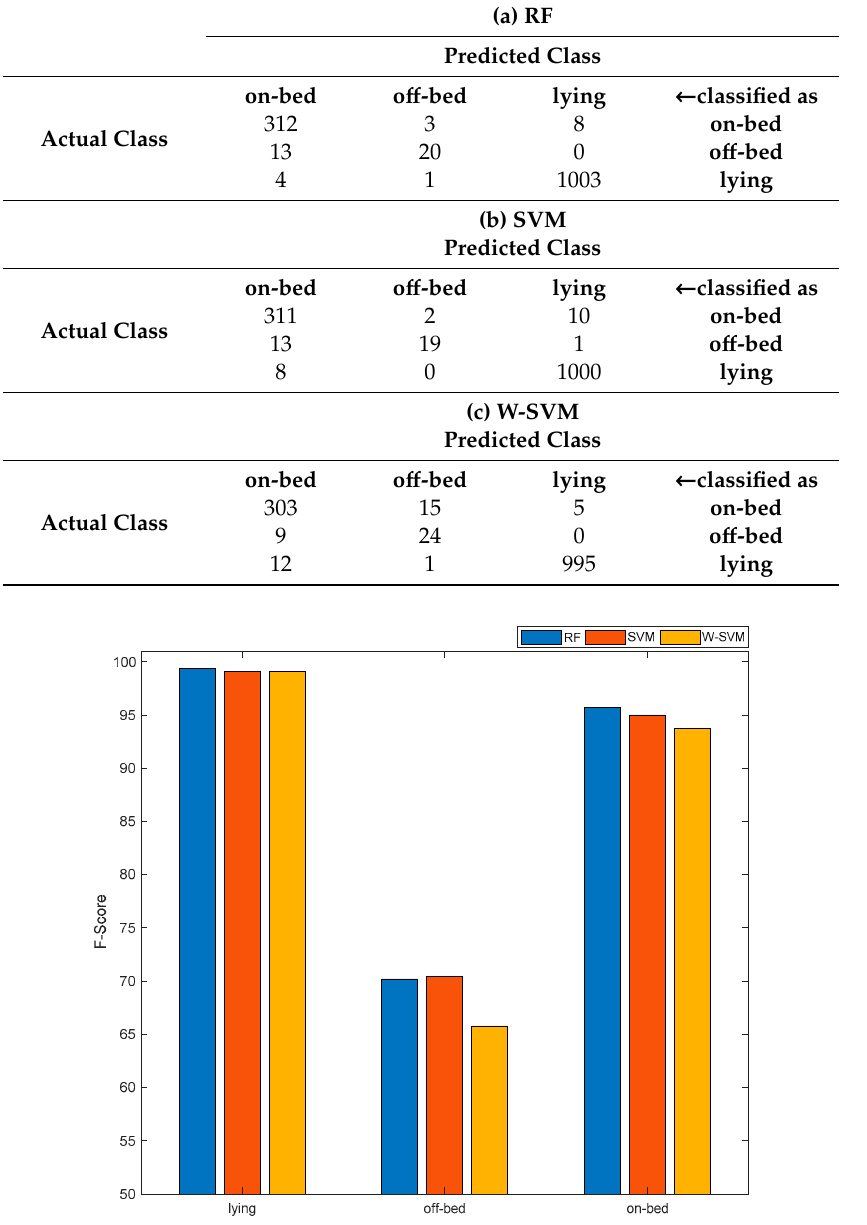
Figure 6. Performance analysis of RFID data on different ADLs using various classifiers.